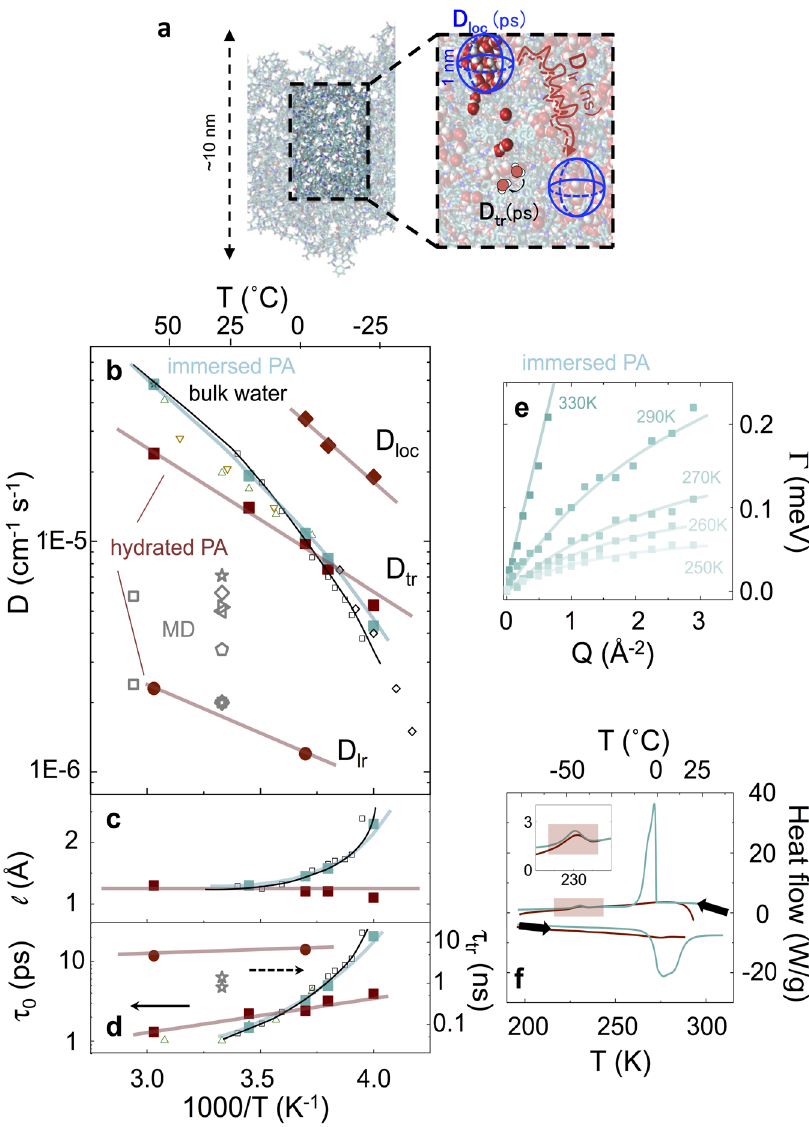
Fig. 5 Con fi ned water-diffusion map and contrast with bulk water. a Schematic of the experimentally resolved diffusive modes of water con fi ned within PA membranes, namely localized diffusion (blue sphere), translational diffusion, and long-range diffusion (tortuous red arrow). b Translational water- diffusion map showing D tr , D lr and D loc as well as “ bulk ” water diffusion. Present data: water dynamics within PA membranes prepared by vapor hydration BS), and immersed in liquid H 2 O ( TOF); previous QENS measurements of water in PA membranes ( 34 ; 35 ), as well as bulk water